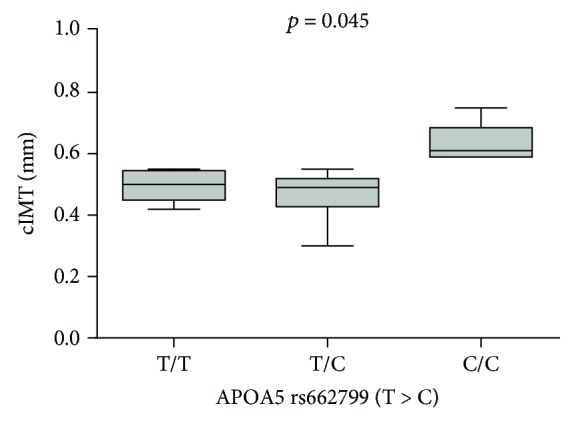
Box-whisker graphs of cIMT values with respect to APOA5 genotypes. Box-whisker plots show the 25th and 75th percentile range (box) with Tukey 95% confidence intervals (whiskers) and median values (transverse lines in the box). p value in figure is relative to Kruskal-Wallis test.